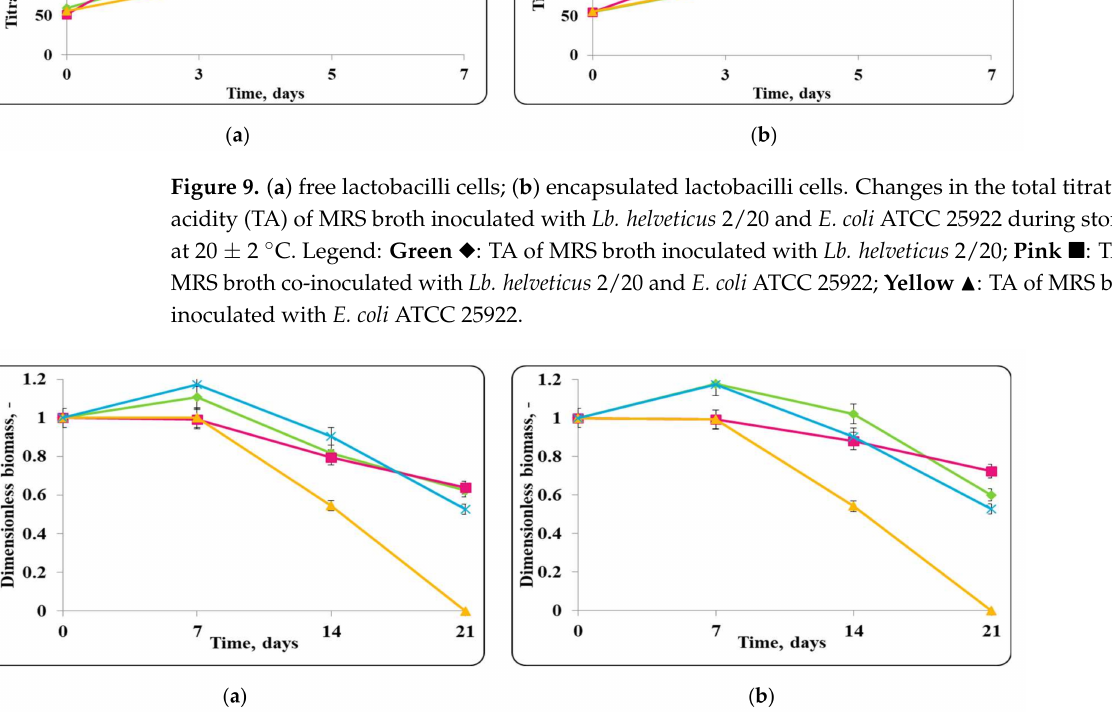
Figure 10. ( a ) free lactobacilli cells; ( b ) encapsulated lactobacilli cells. Changes in the dimensionless biomass of Lb. helveticus 2/20 and S. aureus ATTC 25923 in chocolate mousse at 4 ± 2 ◦ C. Legend: Green (cid:117) : Lb. helveticus 2/20 population following its inoculation; Pink (cid:4) : Lb. helveticus 2/20 population following its co-inoculation with S. aureus ATCC 25923; Blue : × S. aureus ATCC 25923 population following its direct inoculation; Yellow (cid:78) : S. aureus ATCC 25923 population following its co-inoculation with Lb. helveticus